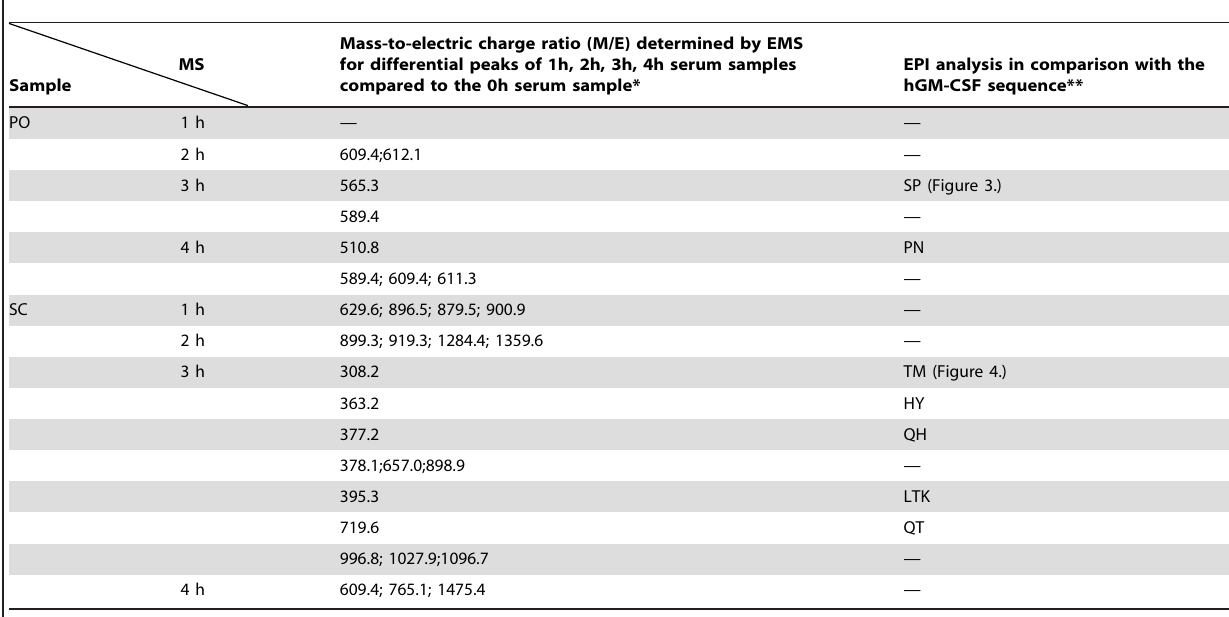
Table 2. EMS and EPI detection results of rhGM-CSF in the serum after either oral administration of BmrhGM-CSF or subcutaneous injection of rhGM-CSF.